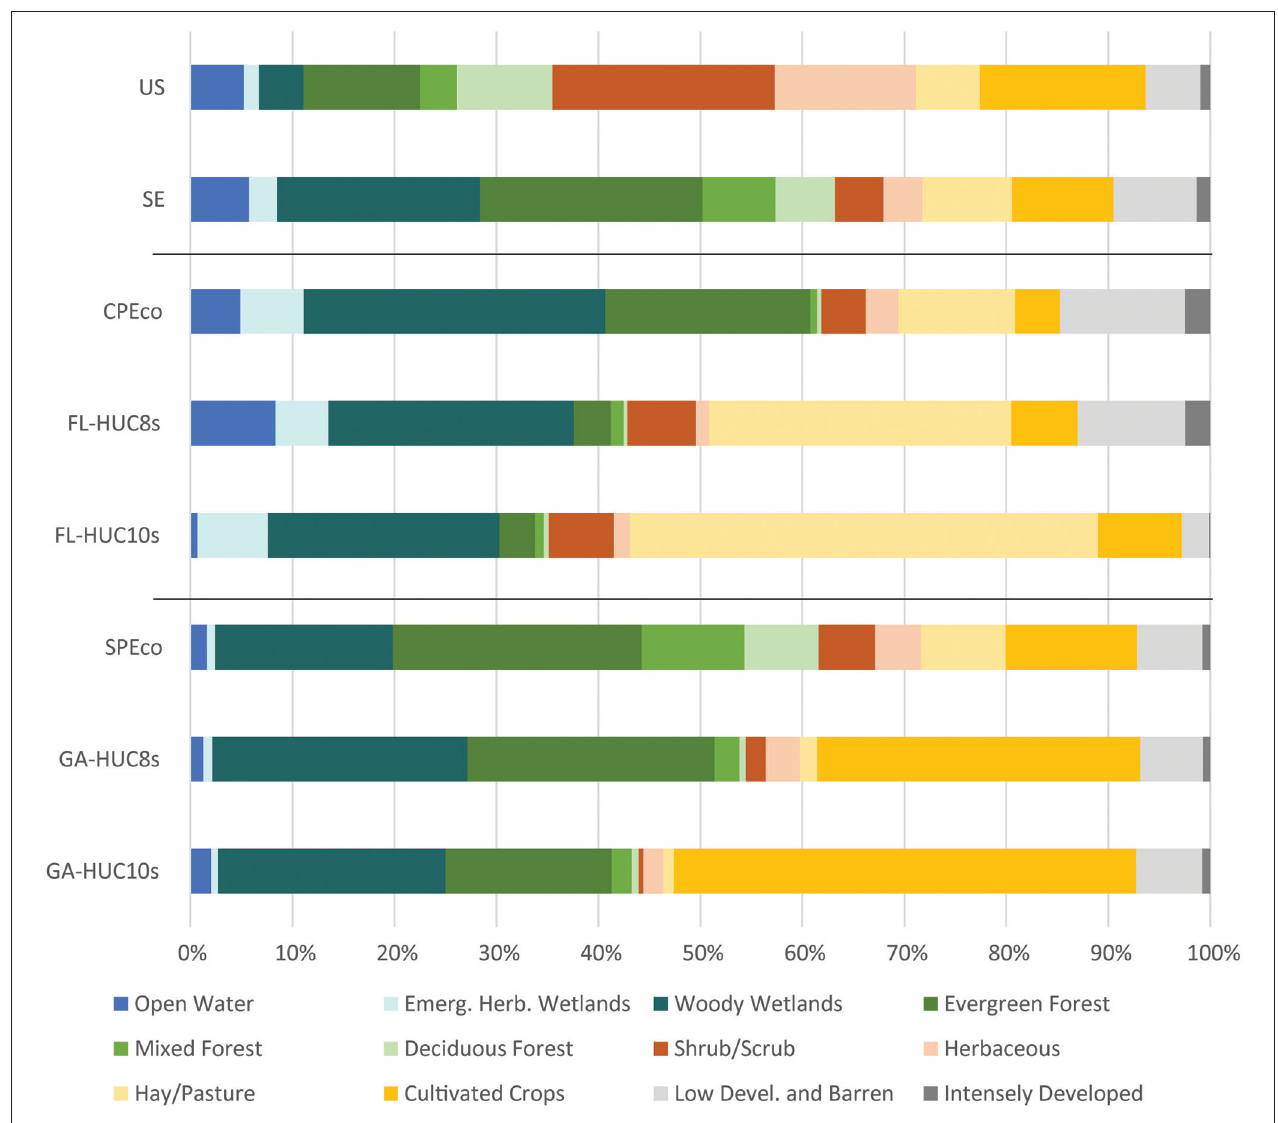
FIGURE 3 | Proportion of land cover type by study region based on the 2016 USGS National Land Cover